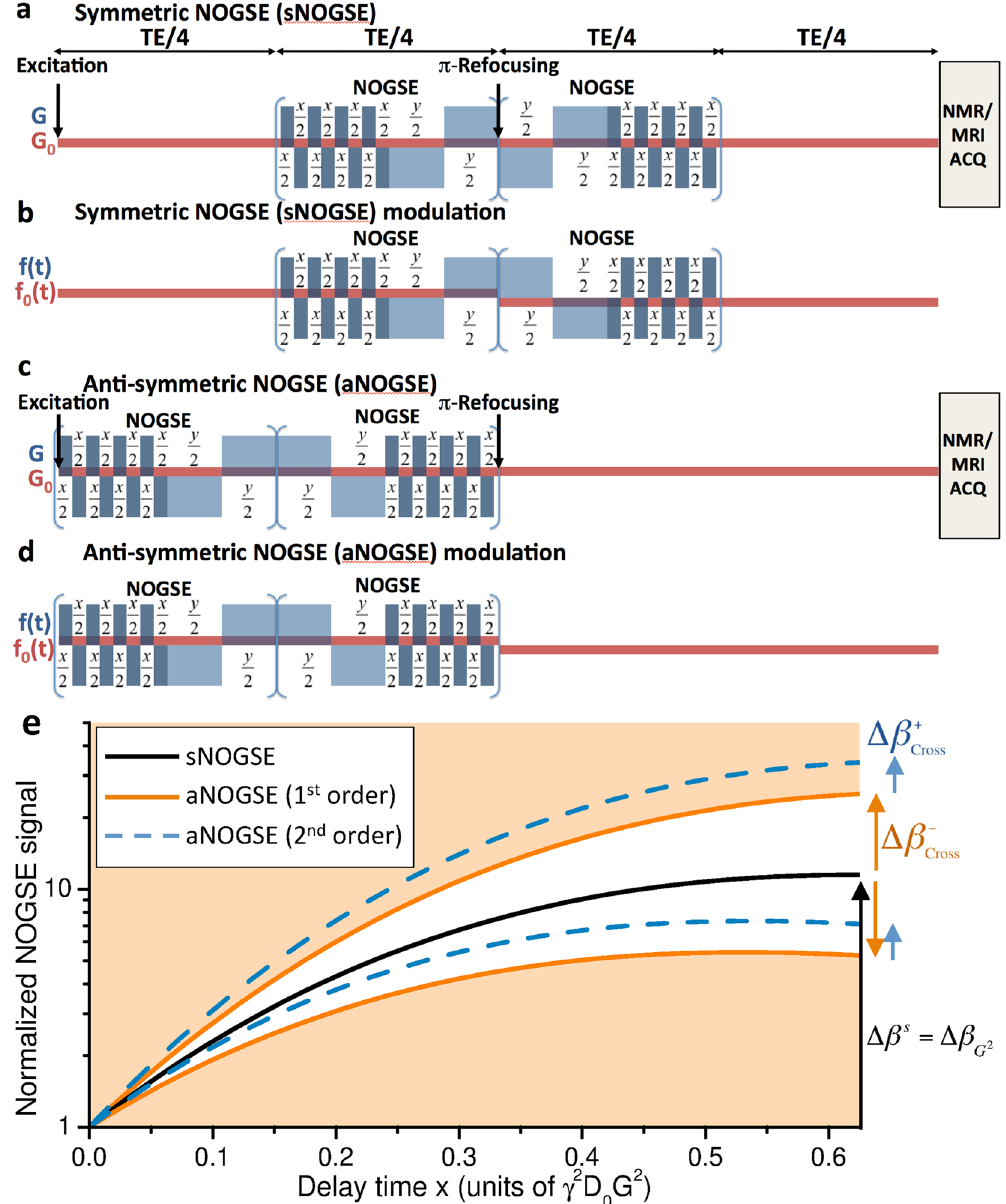
Figure 2. Selective sensing of averages and variances arising from the gradient distributions by ( a ) symmetric- NOGSE (sNOGSE) and ( c ) asymmetric-NOGSE (aNOGSE) sequences. The corresponding modulation waveforms f ( t ) and f 0 ( t ) are shown in panel ( b ) and ( d ) for sNOGSE and aNOGSE respectively. ( e ) Normalized NOGSE signals expected as a function of the delay x , where − + = = N x y TE TE ( 2) 2 /2 . By NOGSE normalizing signals for x ≪ y and then changing x , y while keeping all other parameters – including N and TE – constant, s- and a-NOGSE sequences enable the characterization of the IGDT effects. sNOGSE’ s waveform is symmetric vs the central π refocusing pulse; all cross-terms with the internal gradients are thus zero, freeing the experiment from all internal gradients effects (panel c, black solid line). By contrast, the aNOGSE’ s waveform will be affected by both the 1 st and 2 nd order effects related to the internal gradient cross-terms. The legends describes the different weightings of these attenuation factors stemming from the background gradient distributions. The quantities β Δ − and β Δ + used to selectively determine the average G and variance Cross Cross 0 2 are shown with arrows, where the different signs denote the application of the external gradient G Δ G ( ) 0 , parallel and anti-parallel to the background gradient direction. Other assumptions include = . G G / 0 1 0 Δ = G G / 1 02 and N = 0 → G . In the resulting experiments the β Δ negative gradients, ± contributions will have a first-order cross-term → → ± ⋅ G G 0 → → G and thus have opposite signs, whereas the second-order cross-term is quadratic in G and thus that is linear in